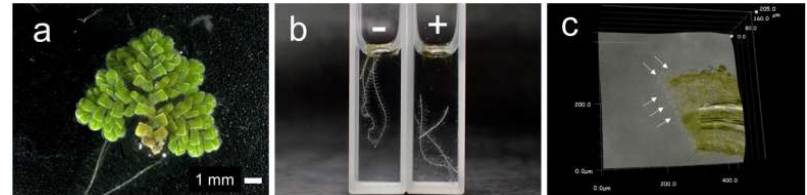
Figure 2. Photographs of root abscission in Azolla pinnata induced by the H 2 S donor 5a. ( a ) Photographs of a frond of A. pinnata . ( b ) Effect of 5a on the root abscission in 10 mM Hepes‐KOH (pH 7.0). Photograph was taken 48 h after the addition of 5a. (−) In the absence of 5a (control), (+) in the presence of 200 µM 5a. ( c ) Expanded cells on the end of a detached root in an abscission zone. The white arrows indicate the expanded cells at end of the detached root.